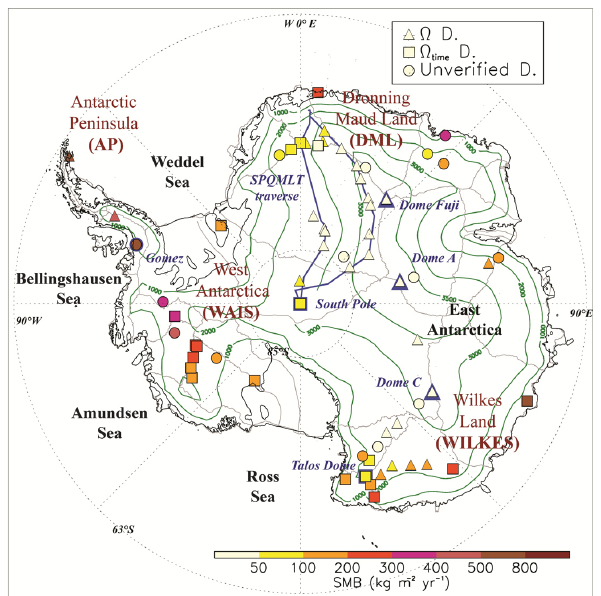
Fig. 1. Geographical distribution of firn/ice core records used in this study along with Surface Mass Balance (SMB) values (kg m − 2 yr − 1 ) and their reliability of the annually resolved time series used for stacked records; triangle: verified data ( (cid:127)) without a tempo- ral series at the annual scale; square: verified data ( (cid:127) TIME ) with a temporal series at annual scale; circle: unverified data with un- known SMB conditions upstream of the core site or sites affected by high SMB spatial variability. Blue lines and symbols highlight the SPQMLT route, Dome Fuji, Dome A, Gomez, South Pole, Ta- los Dome, and Dome C sites respectively. Ice divide positions and altitude isolines are shown in grey and green,